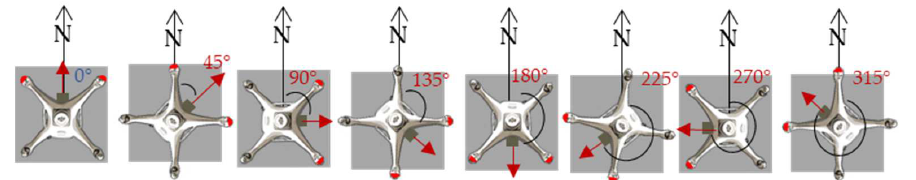
Figure 8. Eight P4-RTK cardinal orientations, with ten repetitions each, to measure P4-RTK antenna accuracy on the ground.